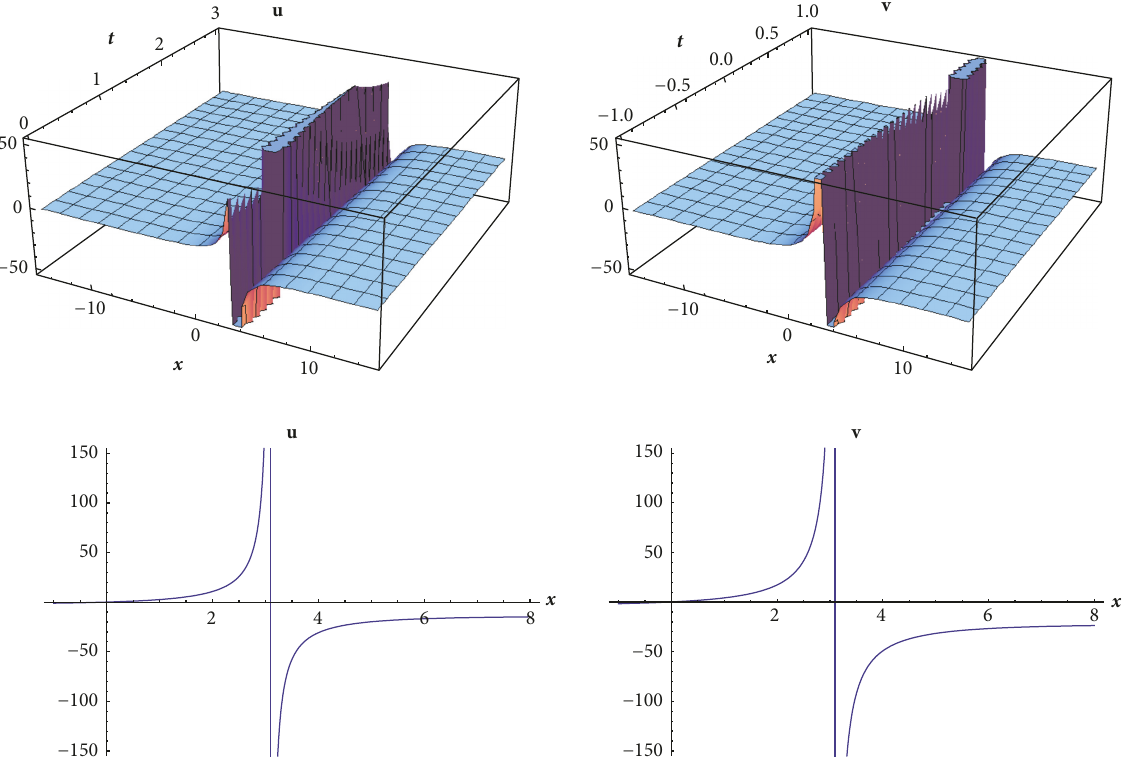
Figure 1: The 3D and 2D surfaces of the solution (22) by considering the values 𝑏 0 = 0.5 , 𝑎 2 = 0.2 , 𝑘 = 1.6 , 𝑊 = 0.3 , 𝑐 = 0.2 , 𝑑 = 0.01 , ∝= 0.8 , 𝜎 = 0.3 , 𝜖 = 0.9 , 𝑦 = 1.5 , and 𝑡 = 0.007 for 2𝐷